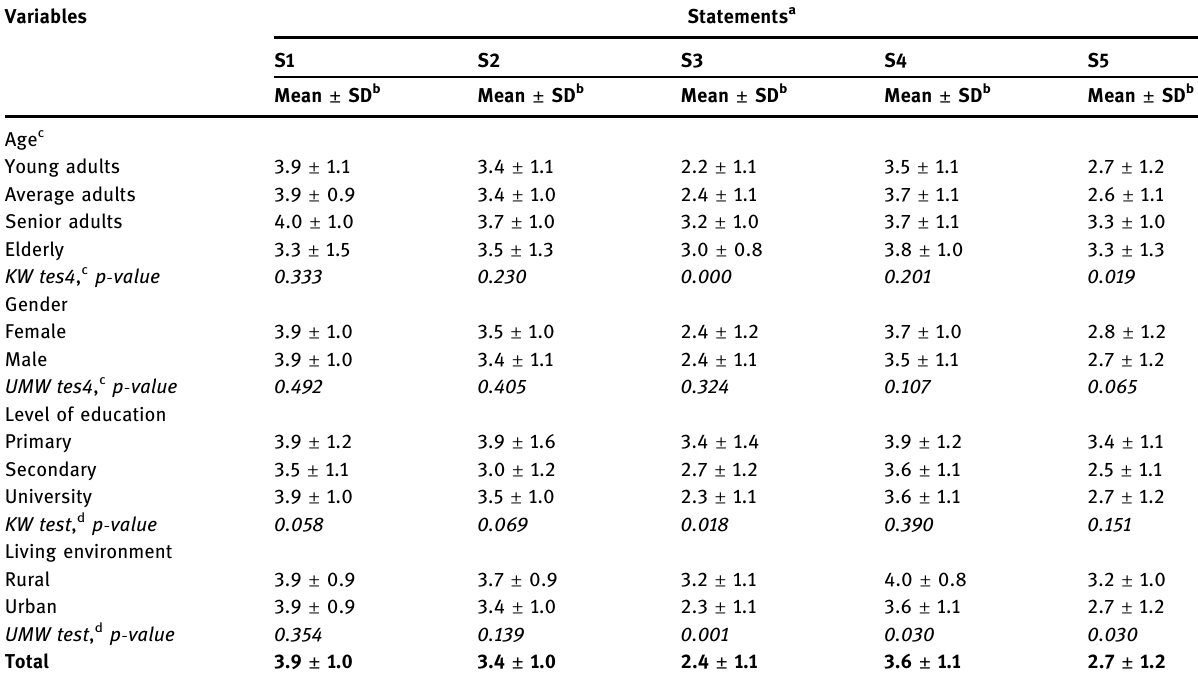
Table 2: Habits towards labelling